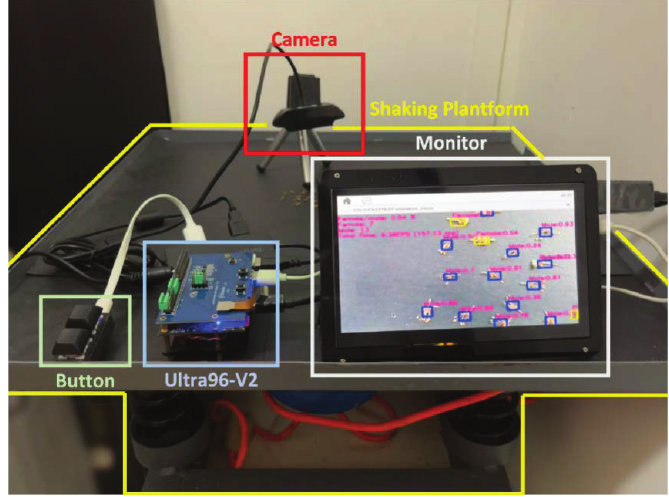
Figure 11. Video streaming test based on FPGA platform. Table 7. Comparison of real-time detection efficiency of different test